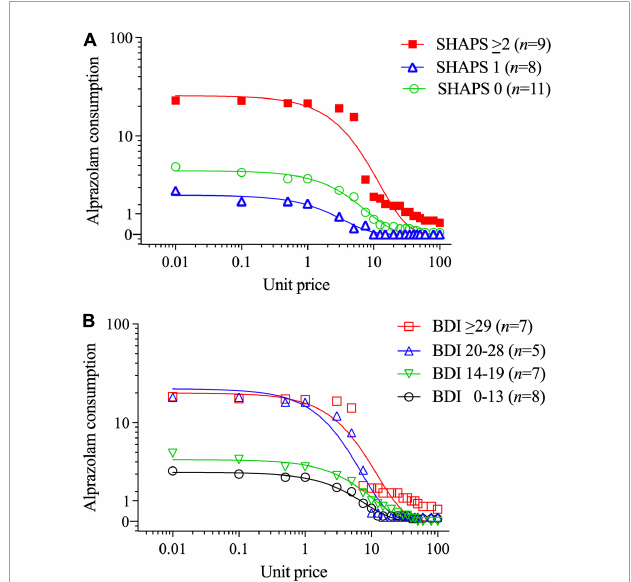
FIGURE3 Alprazolam demand stratified by (A) Snaith-Hamilton Pleasure Scale (SHAPS) anhedonia total scores (0 vs. 1 vs. 2+), and (B) Beck Depression Inventory-II (BDI-II) depression total scores (using clinical cutoff values). The primary SPSS analysis found that participants with higher SHAPS anhedonia scores ( ≥ 2) and higher BDI-II depression symptom scores had significantly higher alprazolam demand intensity (see Section “3.2. Aim 2: Differences within lifetime BZD-misusing subgroups”). Parameters computed in GraphPad Prism from group-average curves in Figure 2A confirm that the subgroup with SHAPS scores ≥ 2 compared to scores of 1 or 0 had higher alprazolam demand intensity ( Q 0 = 25.7 vs. 2.11 vs. 4.22, respectively), and essential value ( EV = 3.11 vs. 0.074 vs. 0.34, respectively), F (1,18) = 78.9. The primary SPSS analysis did not find a significant BDI-II group difference in alprazolam demand intensity or essential value; however, parameters computed in GraphPad Prism from group-average curves in Figure 2B found that progressively increasing BDI-II scores (0–13, 14–19, 20–28, and ≥ 29) were associated with monotonically increasing alprazolam demand intensity ( Q 0 = 1.92, 5.98, 15.7 and 19.9, respectively) and essential value ( EV = 0.26, 0.37, 1.26, and 2.40, respectively), F (1,18) =